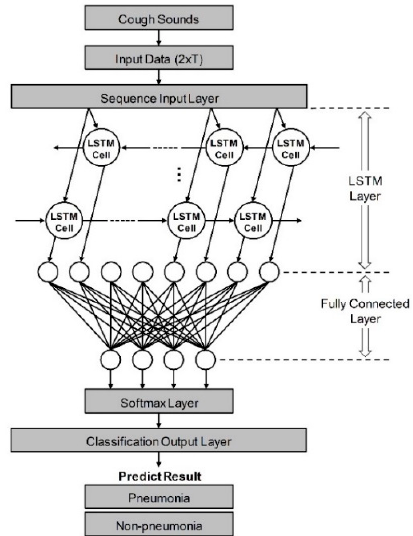
Figure 1. Schematic of LSTM-based machine-learning algorithm for differentiation of pneumonia. Input data from cough sounds include loudness and energy ratio. The algorithm consists of five layers: sequence input, LSTM, fully connected, softmax, and classification output